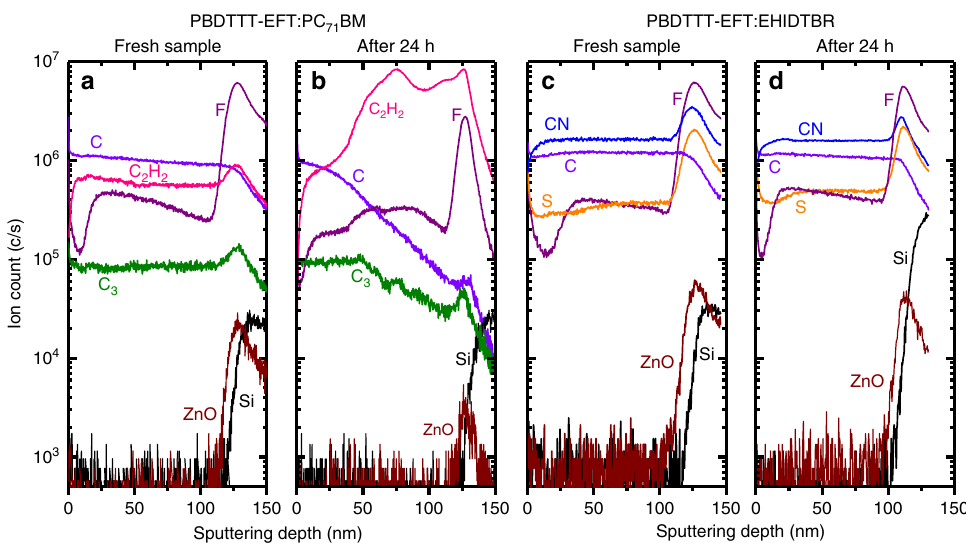
Fig. 5 Depth pro fi les before and after degradation. Negative SIMS depth pro fi ling of PBDTTT-EFT:PC 71 BM ( a , b ) and PBDTTT-EFT:EHIDTBR ( c , d ) blends prior to light radiation and subjected to light radiation equivalent to 24 h. 0 nm sputtering depth represents the top surface and 150 nm shows the